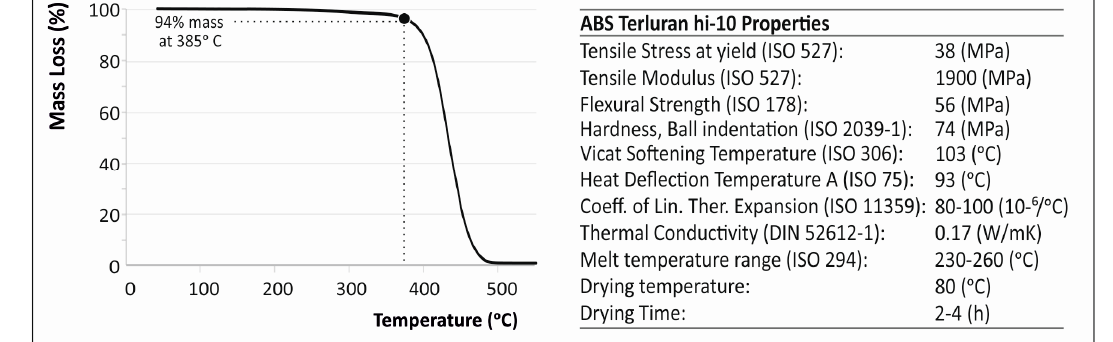
Figure 5. Thermogravimetric analysis (TGA) mass loss versus temperature curve for the ABS Terluran Hi-10 experimentally determined in this work and ABS polymer matrix manufacturer properties (courtesy of Ineos Styrolousion, material datasheet).